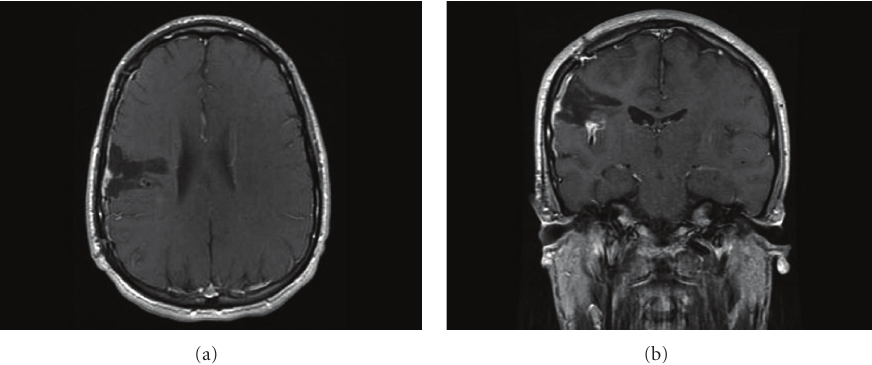
Figure 4: T1-weighted axial (a) and coronal (b) MRI at the 1-year postoperative visit show encephalomalacia, no increase in size of residual lesion, and persistent enhancement in sylvian cistern.